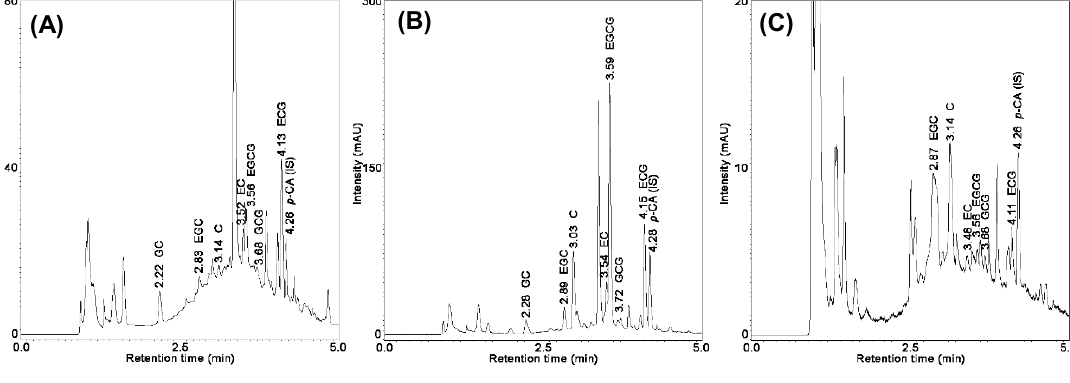
Figure 5. Representative chromatograms obtained for an extract of leaves of ( A ) black tea, ( B ) green